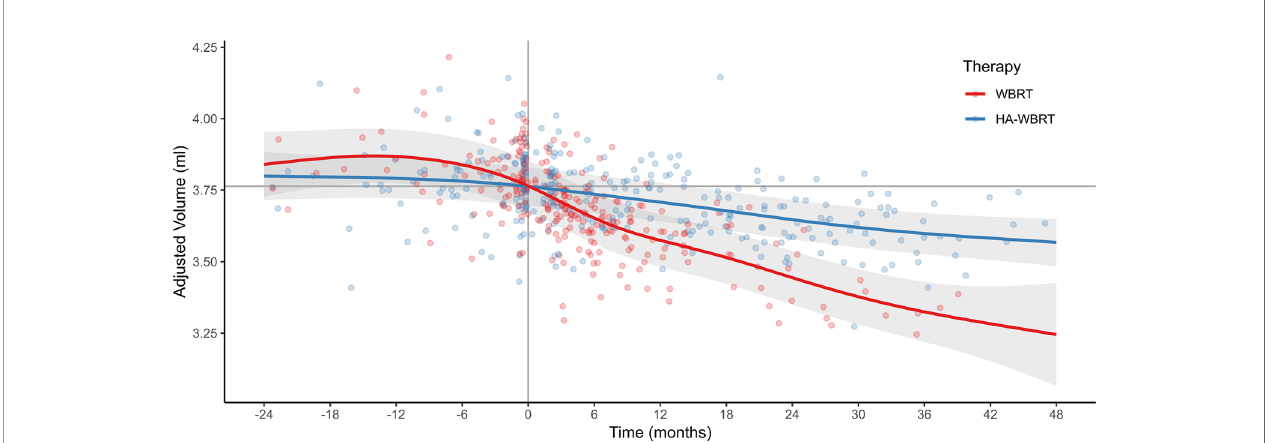
FIGURE 3 | Evolution of hippocampal atrophy 24 months before and 48 months after WBRT versus HA-WBRT (averaged for left and right hippocampus) across time (with the gray vertical line denoting the time of RT and the gray horizontal line depicting the average hippocampal volume at the time of RT as reference). The two treatment groups, WBRT and HA-WBRT, show signi fi cantly distinct time courses. Dots represent individual data points, and bands represent standard errors. Adjusted volume refers to the estimated marginal means after accounting for variation of nuisance variables (effects of age, gender, TIV, patient, and MR scanner). The number of patients with adequate imaging studies still in follow-up was n = 49 at 6 months, n = 29 at 12 months, n = 14 at 24 months, and n = 5 at 36 months. HA-WBRT, hippocampus-avoidance whole-brain radiation therapy; WBRT, whole-brain radiation